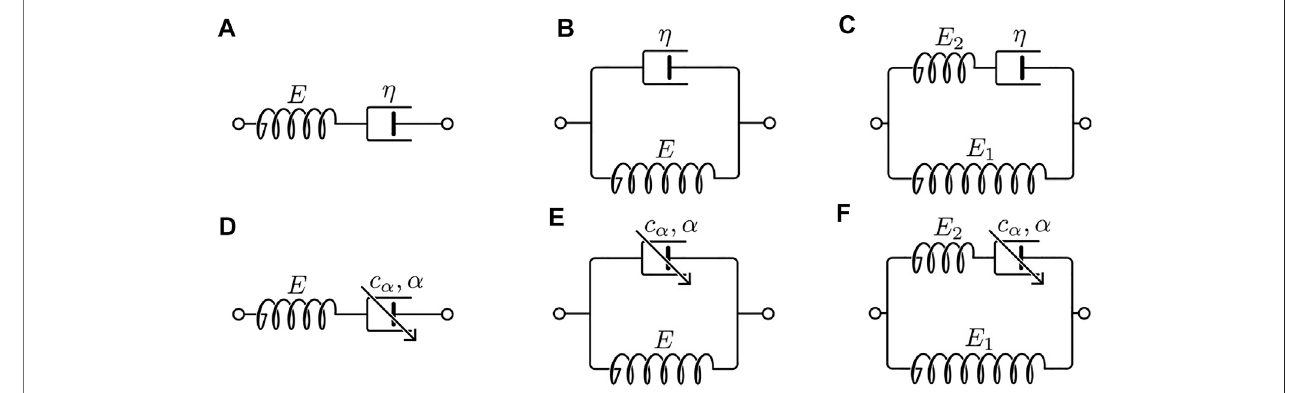
FIGURE 2 | Schematics of the classical rheological models and their fractional analogs. (A) Maxwell, (B) Kelvin – Voigt, (C) Zener, (D) fractional Maxwell, (E) fractional Kelvin – Voigt, and (F) fractional Zener.